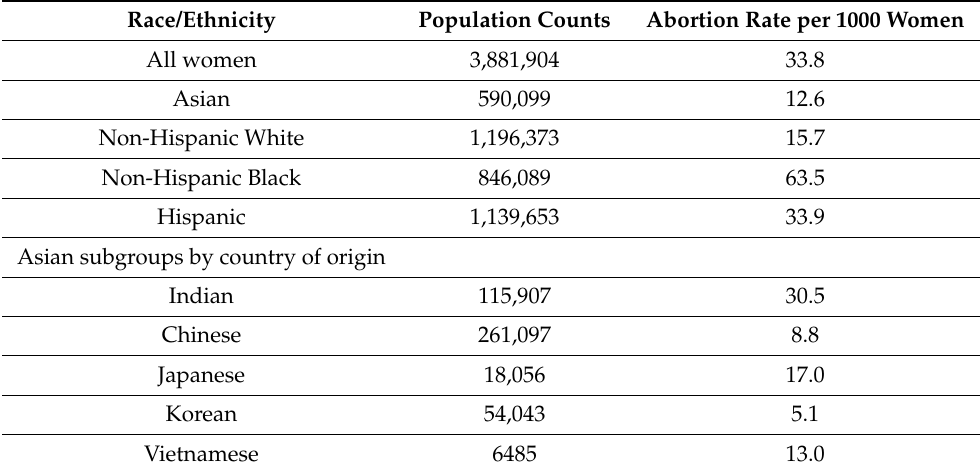
Table 1. Age-standardized abortion rates among New York City women by race, ethnicity, and country of origin: 2014–2015.